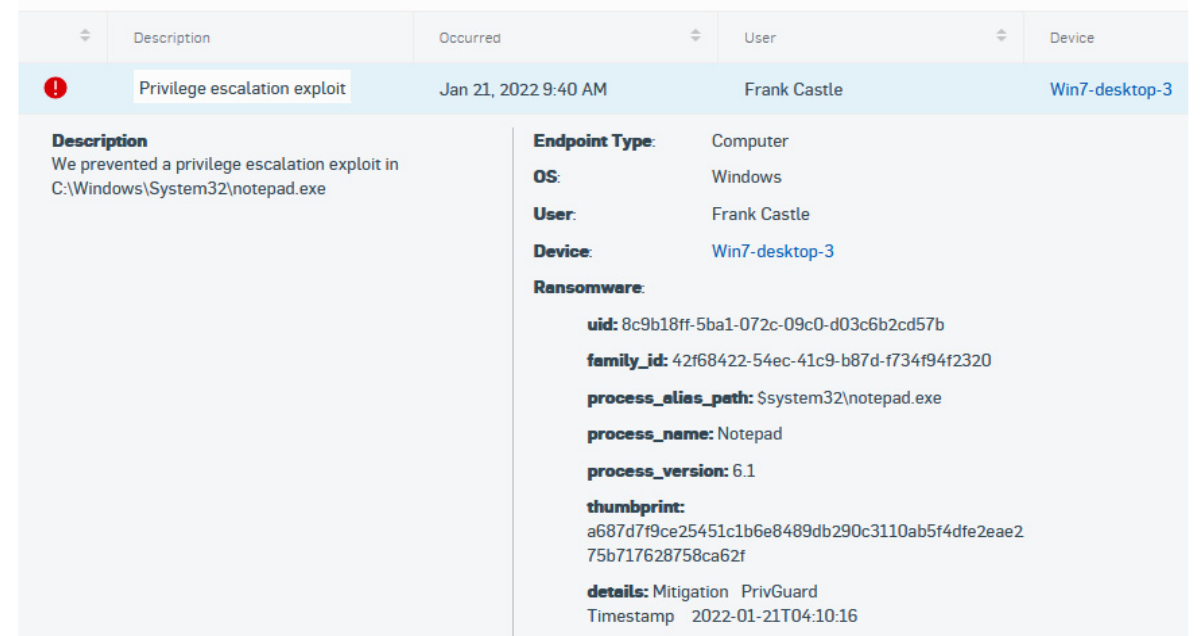
Figure 18. Privilege escalation identified.